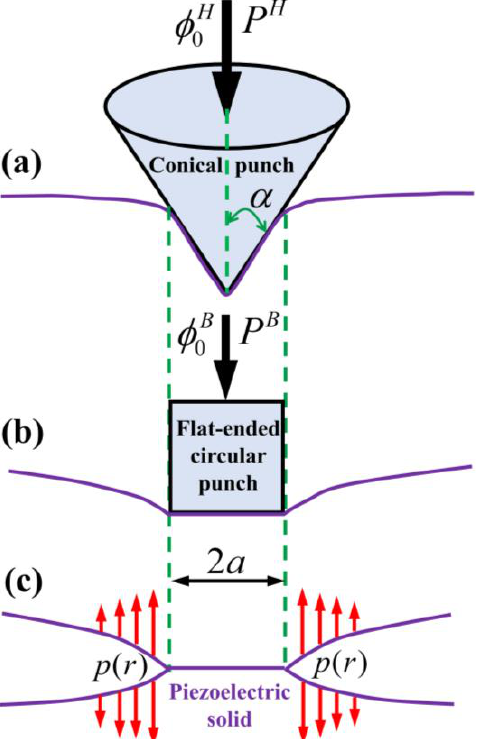
Figure 2. Illustration of the M-D model of a conical punch on a piezoelectric solid: ( a ) Hertz piezoelectric contact for a conical punch. ( b ) Boussinesq piezoelectric contact for a flat-ended circular punch. ( c ) An axisymmetric external crack in an infinite piezoelectric body.